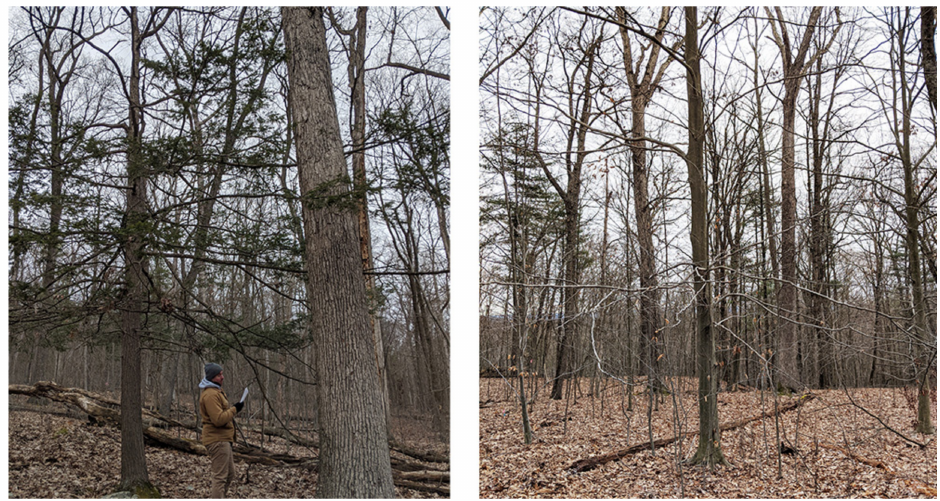
Figure 18. Eastern hemlock branches resulted in a false positive ( left ) as did the branching pattern of an American beech ( right ). These are the two false positives where phantom trees were detected.